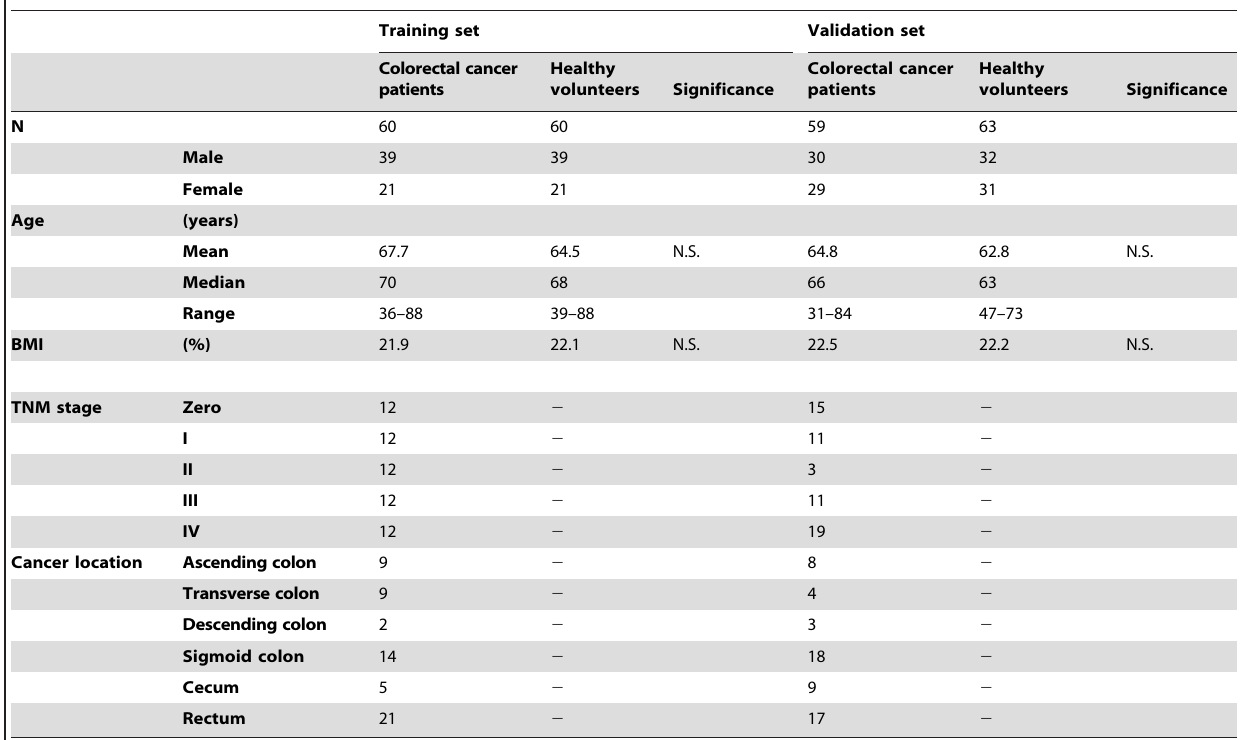
Table 1. Subject information for the training and validation